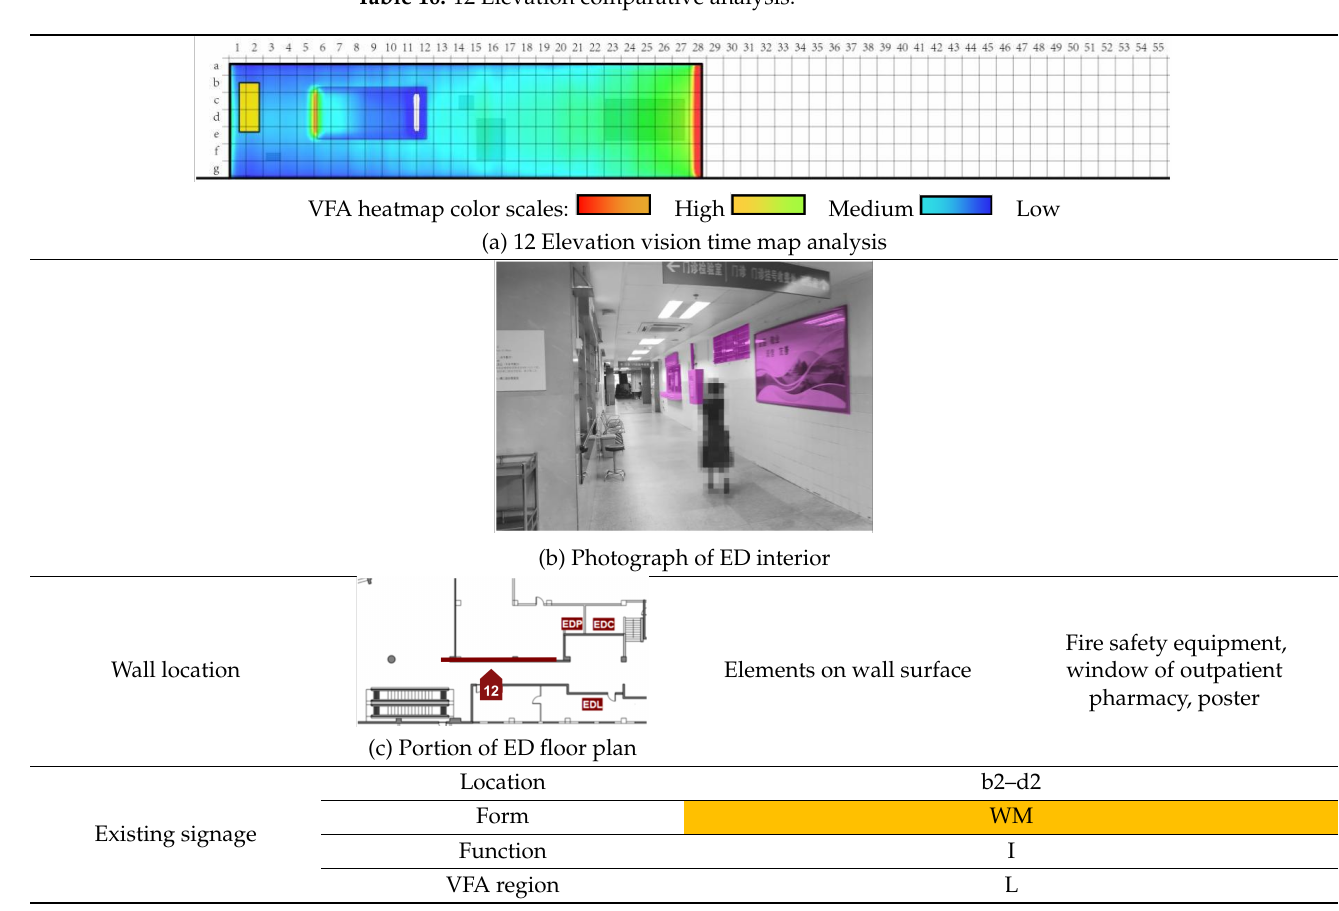
Table 16. 12 Elevation comparative analysis.